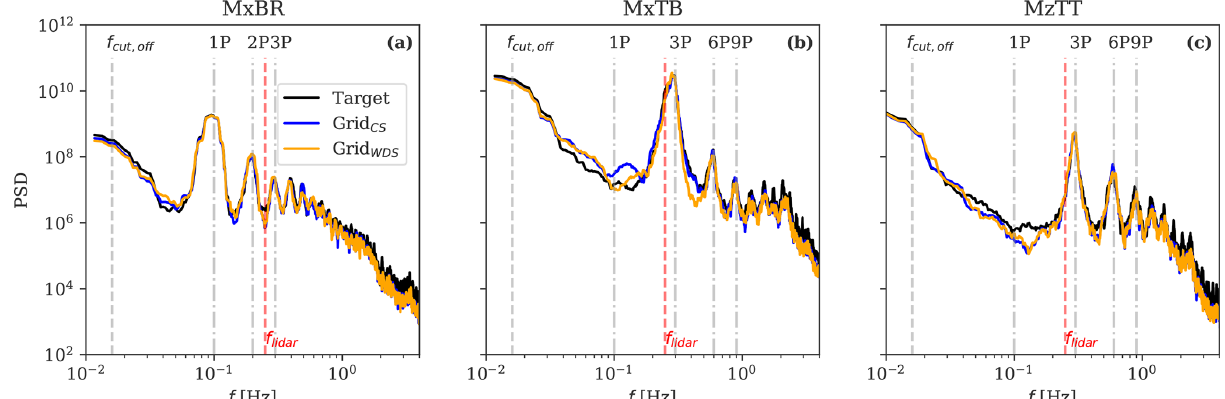
Figure A1. Power spectral density (PSD) of the (a) blade root flapwise bending moment MxBR, (b) tower-bottom fore-aft bending moment MxTB, and (c) yaw moment MzTT. The dominant frequency of the wake meandering f cut,off = 0 . 016Hz; the Nyquist frequency of the lidar f lidar = 0 . 25Hz (corresponding to the scanning period); and the main rotational frequencies 1P, 2P, 3P, 6P, and 9P are shown. The target simulations are run at 6ms − 1 with TI amb =